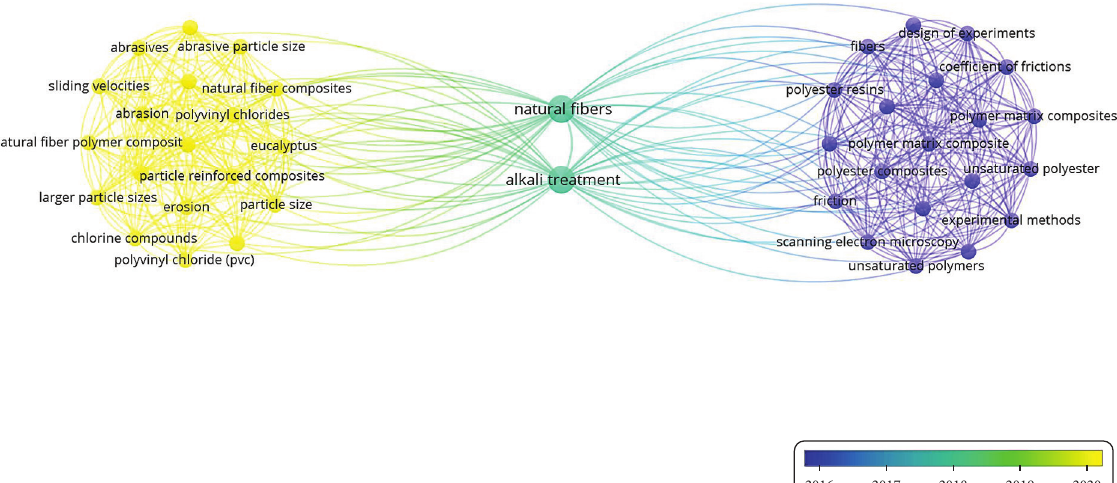
Figure 15: Systematic mapping summary of scientific advancements regarding the influence of alkali treatment and MAPP compatibilizing agent on physicomechanical and sliding wear tribological characteristics of natural fiber-reinforced polymer composites for engineering